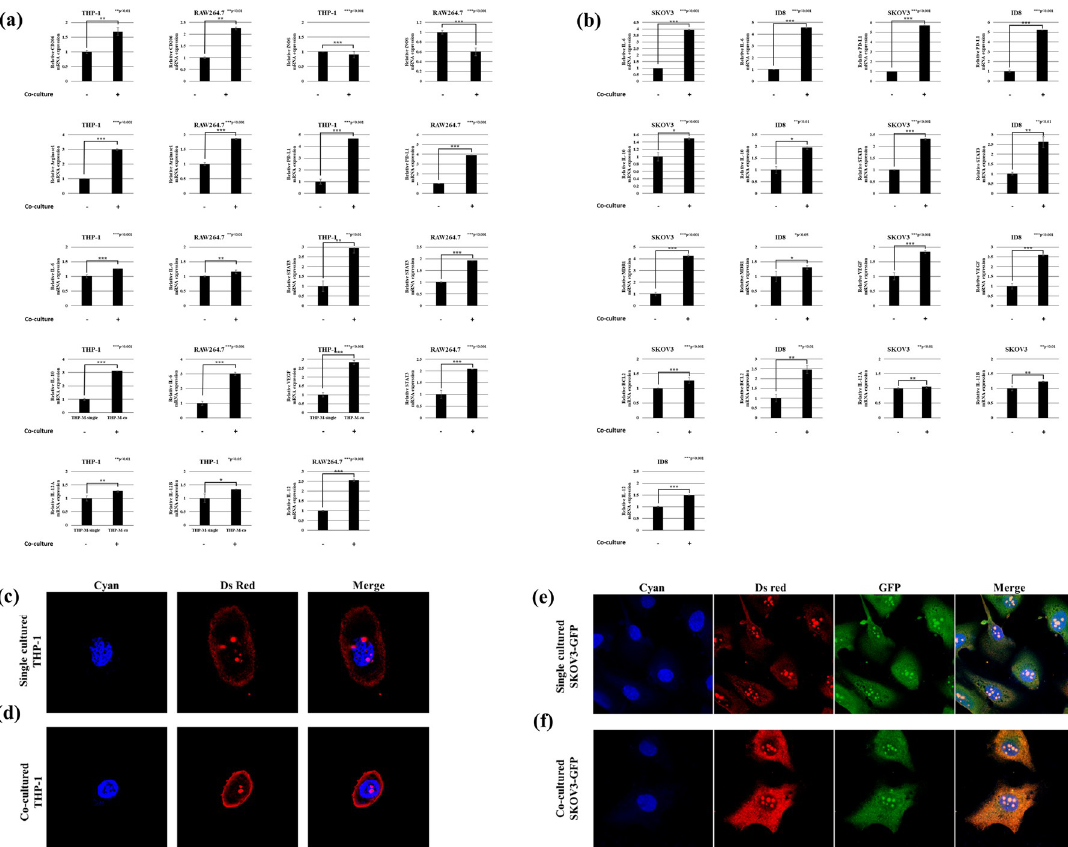
Fig 2. Gene expression in ovarian cancer cells and macrophages following co-culture. (a) mRNA expression of the M2/M1 markers in macrophages following co-culture. (b) mRNA expression of various genes related to chemoresistance and angiogenesis in co-cultured ovarian cancer cells. Immunofluorescence images of (c) single-cultured THP-1 cells, (d) co-cultured THP-1 cells, (e) single-cultured SKOV3-GFP cells, and (f) co-cultured SKOV3-GFP cells. The cyan color represents Hoechst 33342-stained nuclei observed at 440–480 nm with 358 nm excitation. The green color represents the green fluorescence-stained cytoplasm of SKOV3-GFP cells observed at 460– 580 nm with 488 nm excitation. Ds Red color represents the fluorescence of PD-L1 observed at 500–700 nm with 480 nm excitation.